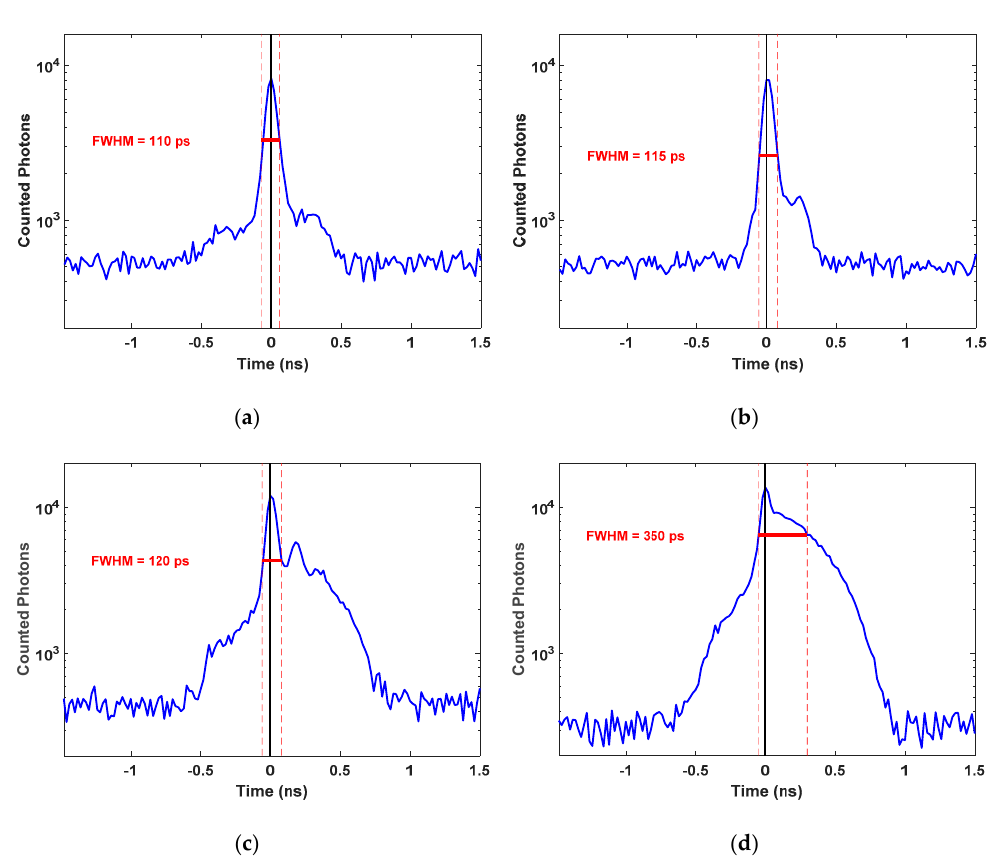
Figure 8. FWHM of IRF Total of the TR-DOS prototype at two different wavelengths used in this work: ( a ) 685 nm at low optical power (0.05 mW); ( b ) 830 nm at low optical power (0.06 mW); ( c ) 685 nm at the used optical power (2.2 mW) to illuminate the phantoms; and ( d ) 830 nm at the used optical power (3.6 mW) to illuminate the phantoms.